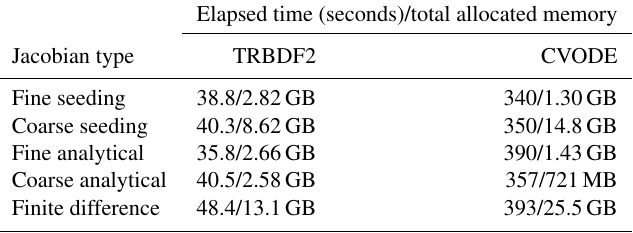
Table B1. Elapsed time and total allocated memory of the multi-phase APINENE simulation in Sect. 4.1 with different ODE solvers and Jacobian matrix evaluation techniques.